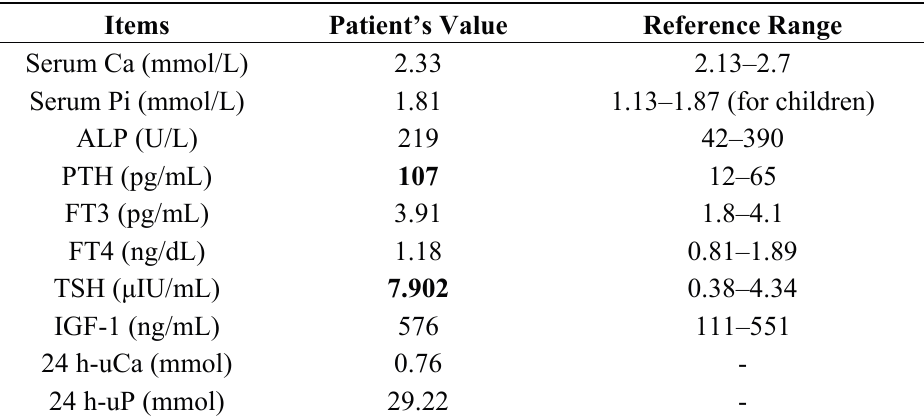
Table 1. Biochemical measurements of the patient.